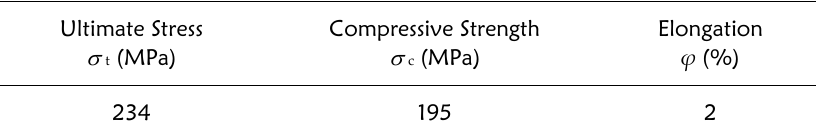
Table 2: Mechanical properties of Aluminium alloy,